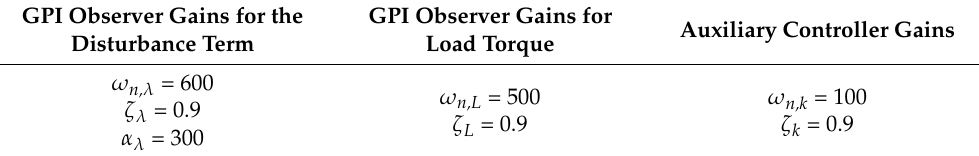
Table 4. GPI observer and auxiliary controller